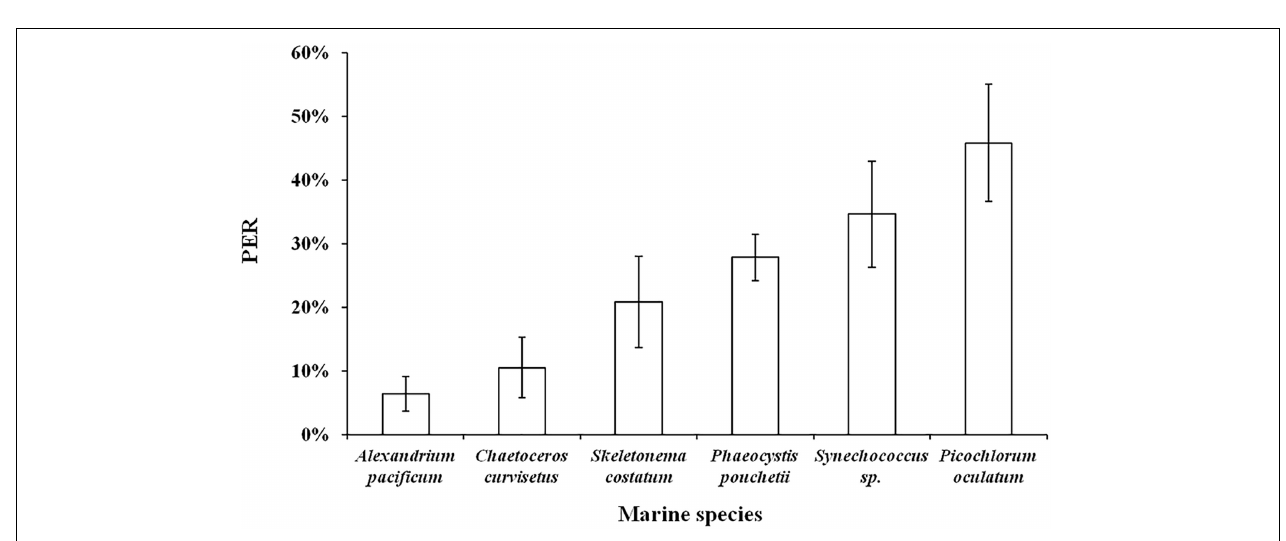
FIGURE 8 | The relationship between size-fractionated Chl a and percentage of extracellular release [ (A) Chl a ( micro ) and PER, (B) Chl a ( Nano ) and PER, (C) Chl a ( Pico ) , and PER] during SW and NE monsoon in the Qinzhou Bay.